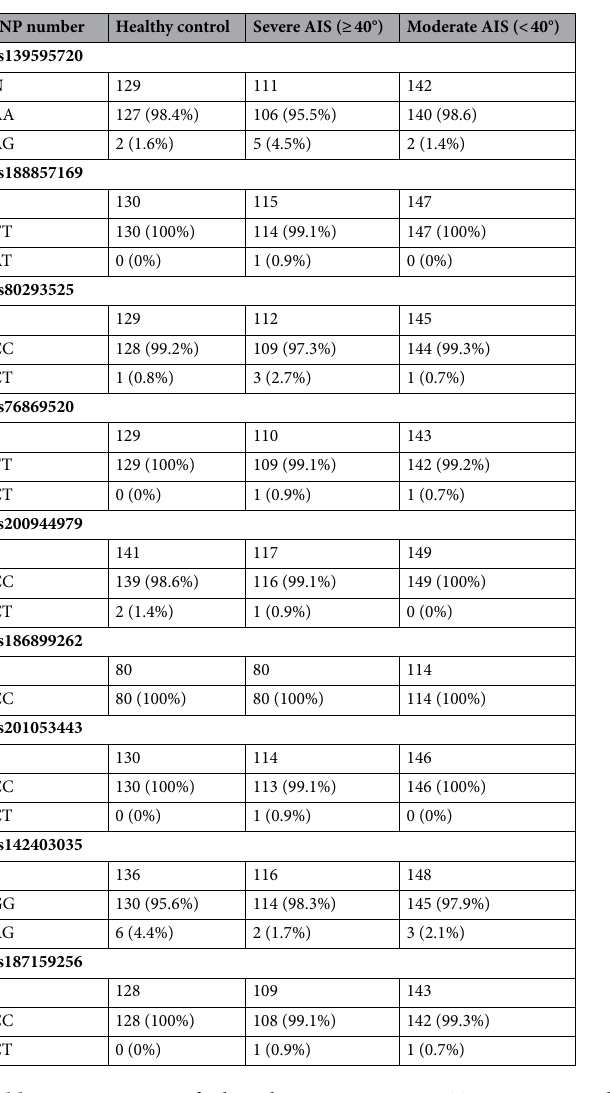
Table 7. Genotyping of selected nine variants in FAT3 gene in second replication AIS